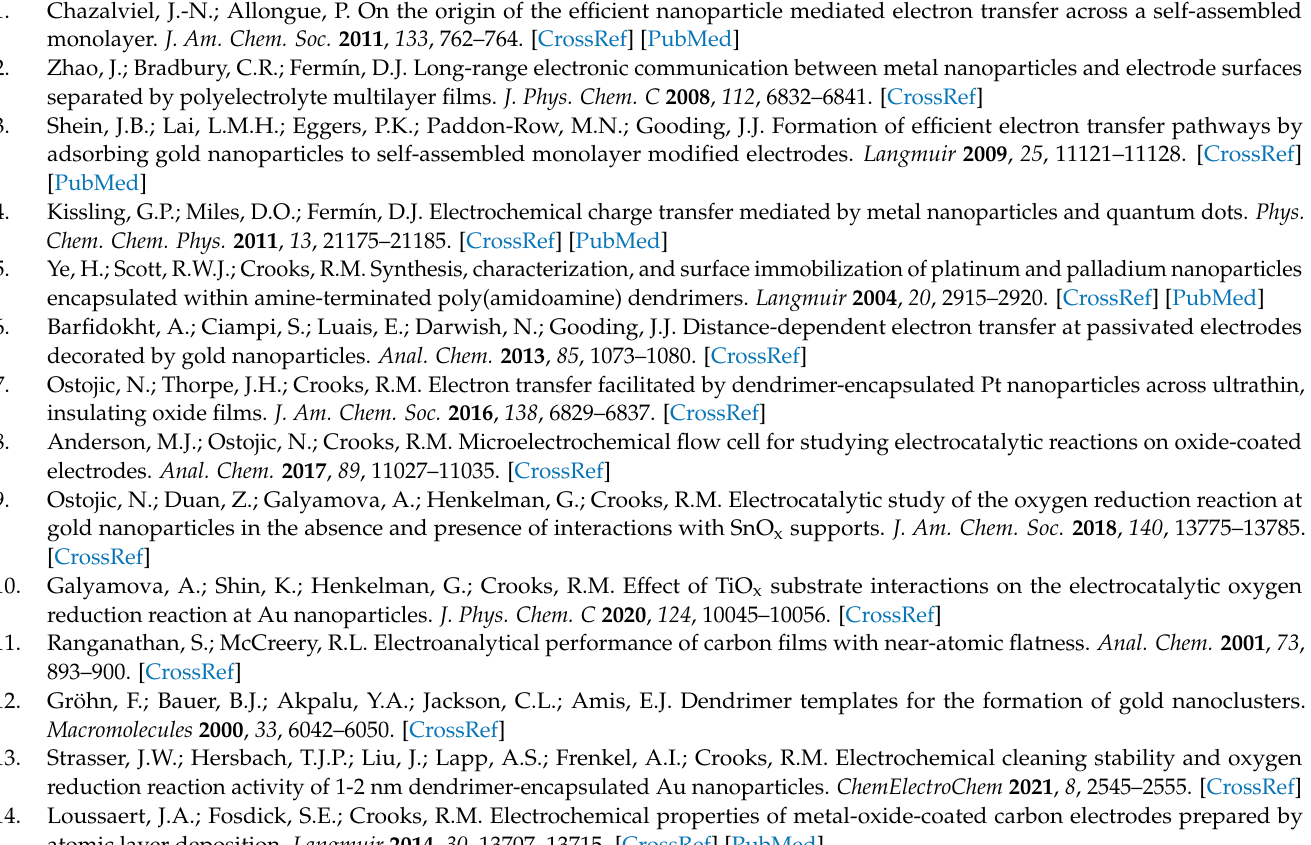
Figure S5: CV overlay of Fc(MeOH) 2 redox probe at PPF, PPF/TiO 1.9 and PPF/TiO 2.0 working electrodes, Figure S6: CVs of ORR on PPF/TiO 1.9 (2.3 nm)/Au 147 in acidic and alkaline media, Figure S7: CVs of CO electrooxidation on PPF/TiO x /Au 147 with varying TiO x thin film thicknesses, Figure S8: CV overlay of Fc(MeOH) 2 redox probe at PPF, and PPF/Al 2 O 3 working electrodes, Figure S9: CVs of CO electrooxidation on PPF/Al 2 O 3 /Pt 55 with varying Al 2 O 3 thin film thicknesses, Figure S10: CV overlay of pH 3.1 phosphate buffer at PPF/TiO 1,9 , and PPF/TiO 2.0 working electrodes. Refs. [7,10,27,33] cited in Supplementary